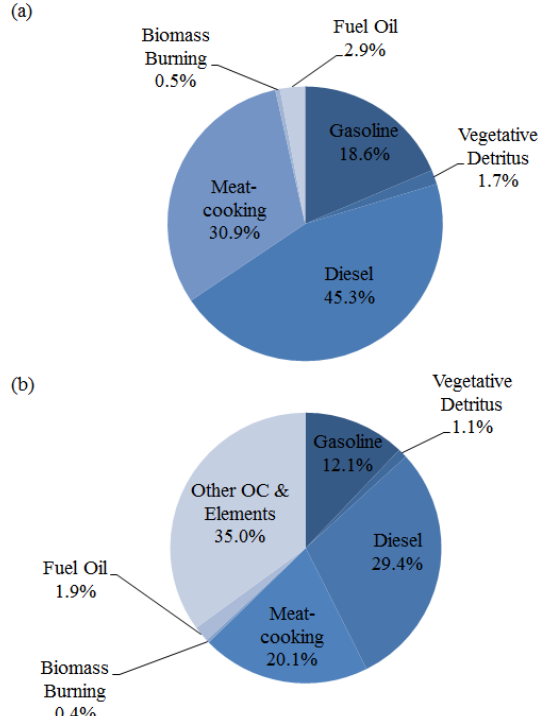
Figure 6. CMB contributions to the (a) average identified ambi- ent PM 2 . 5 in the MMA and to the (b) overall PM 2 . 5 including the unidentified mass of the measured PM 2 . 5